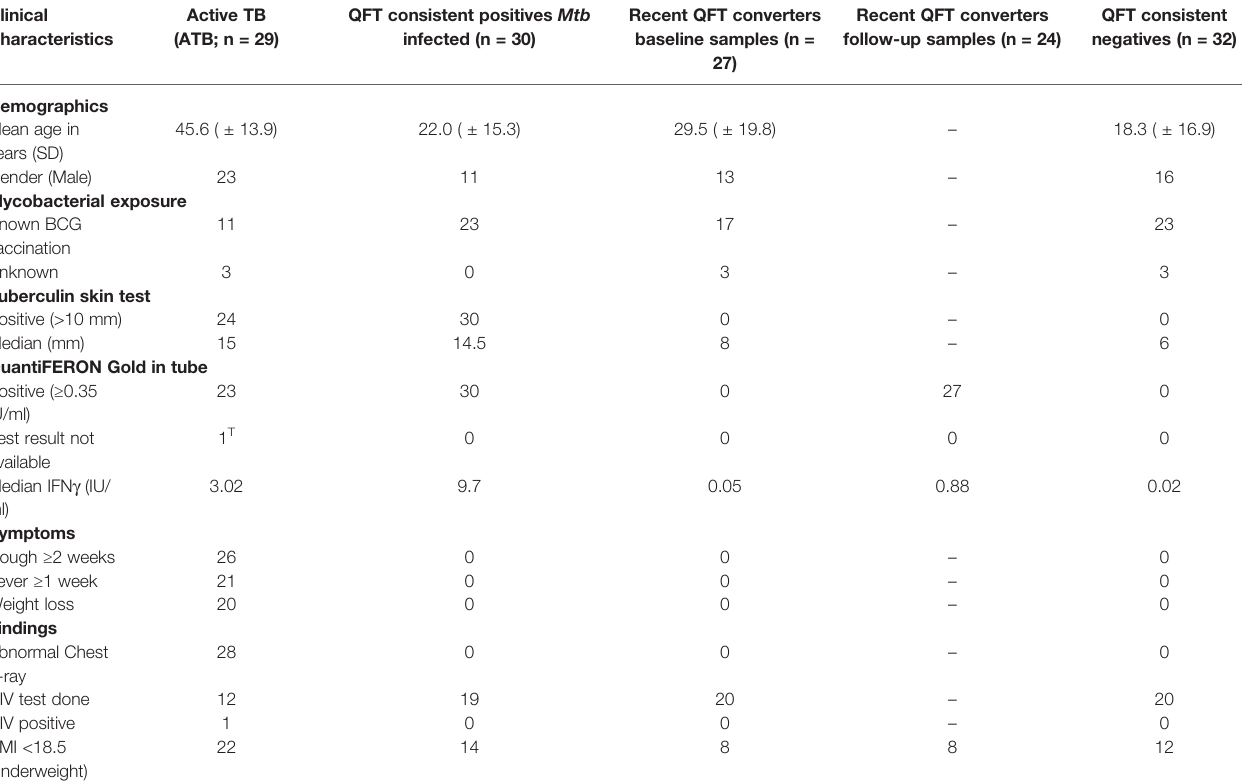
TABLE 1 | Clinical Characteristics of the study groups. Clinical